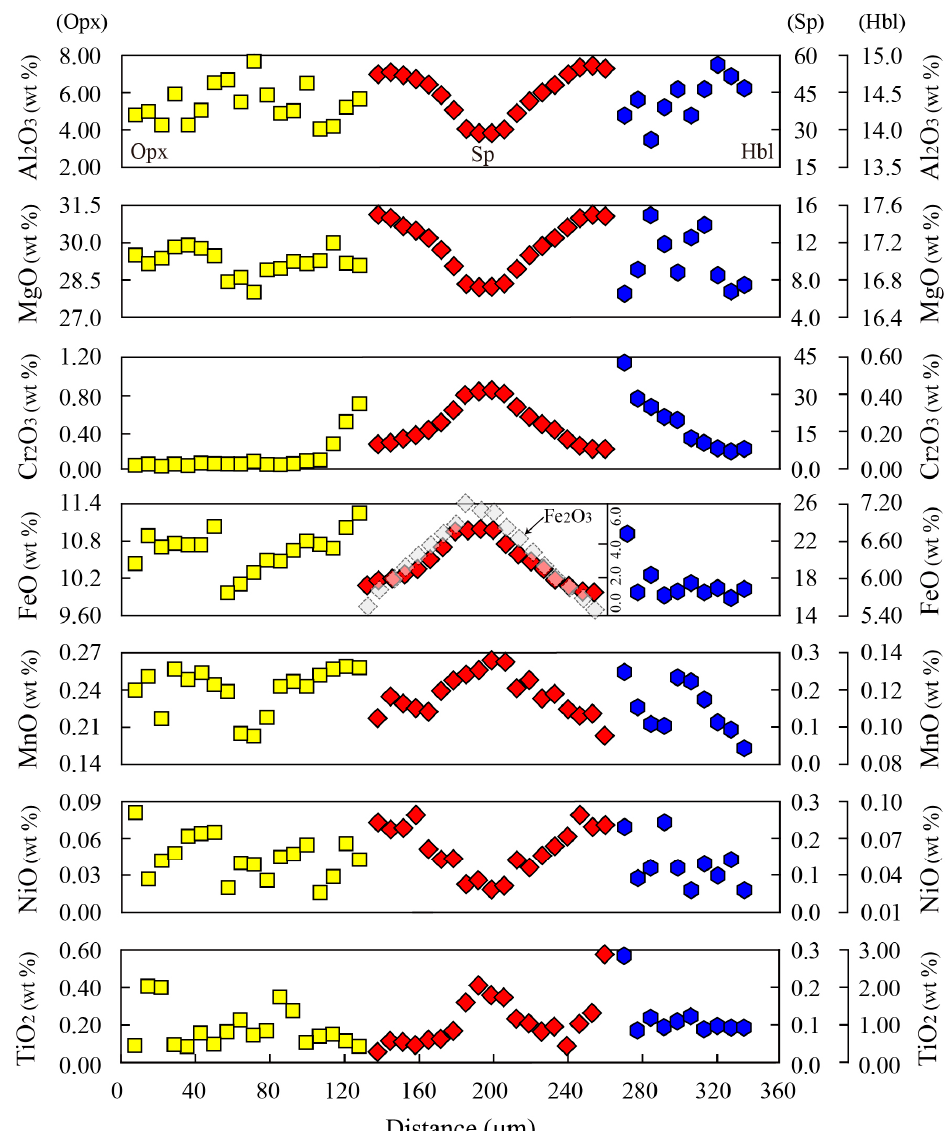
Figure 5. Compositional profile analyses of zoned Cr-spinel located between enstatite and tschermakite. The profile shows in Figure